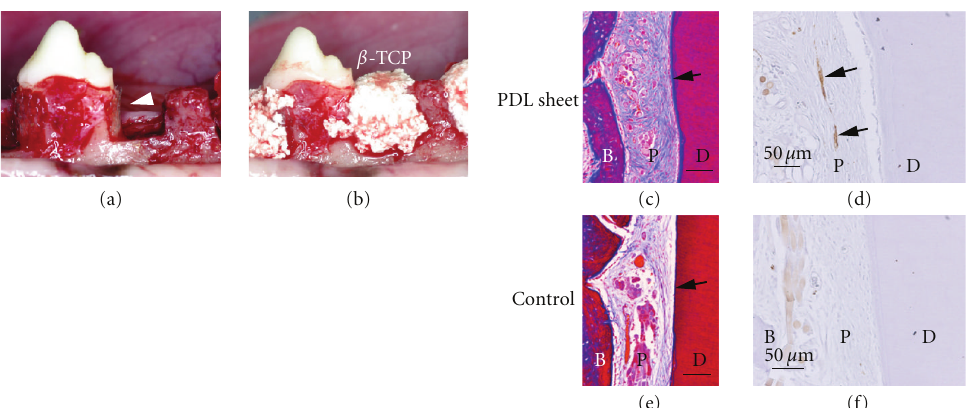
Figure 1: Periodontal tissue regeneration using PDL cell sheets. (a) Sheets of polyglycolic acid (arrowhead) with or without the cell sheets were applied onto the root surfaces of canine mandibular premolars. (b) Bone defects were filled with β -TCP. (c, e) Thick, newly formed cementum (arrow) and dense collagen fibres were observed in the PDL of the PDL sheet-transplanted group. (d, f) The immunohistochemi- cal detection of neurofilament protein revealed that newly formed nerve fibres were only observed in the group given the PDL sheets (arrow). Scale bars: 100 μ m in (c) and (e); 50 μ m in (d) and (f). B: newly formed bone, P: periodontal ligament, and D: root dentin. Modified from [13] with